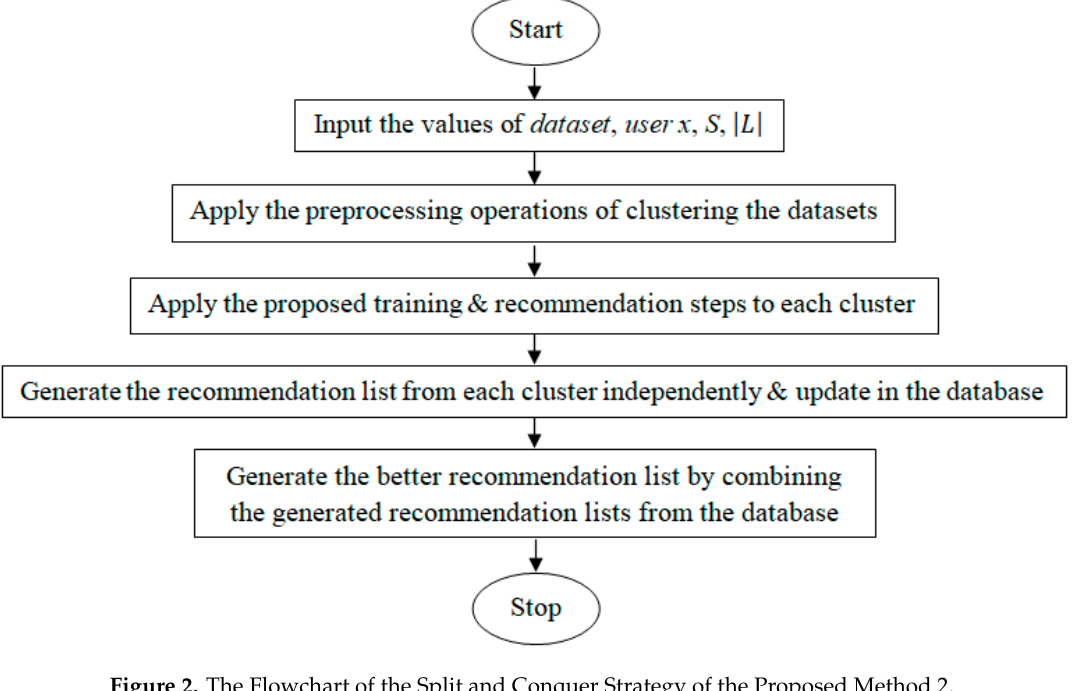
Figure 2. The Flowchart of the Split and Conquer Strategy of the Proposed Method